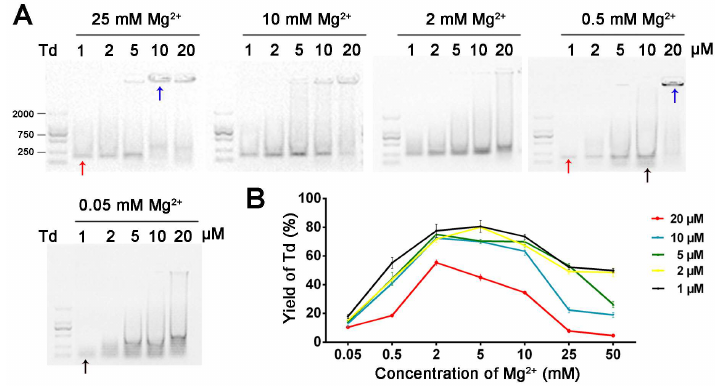
Figure 2. The influence of Mg 2 + and Td concentrations on preparing Td in micromolar ranges. ( A ) Agarose gel of 1, 2, 5, 10 or 20 µ M DNA products under various Mg 2 + concentrations. ( B ) Yield curve of Td versus Mg 2 + and Td concentrations. Red, blue and black arrows represent successfully assembled Td, aggregated DNA and free DNA strands,